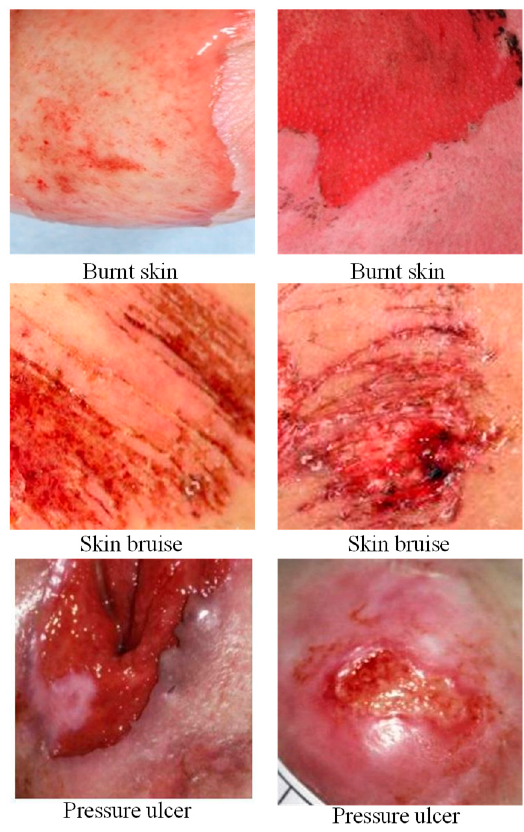
Figure 1. Sample of dataset images .